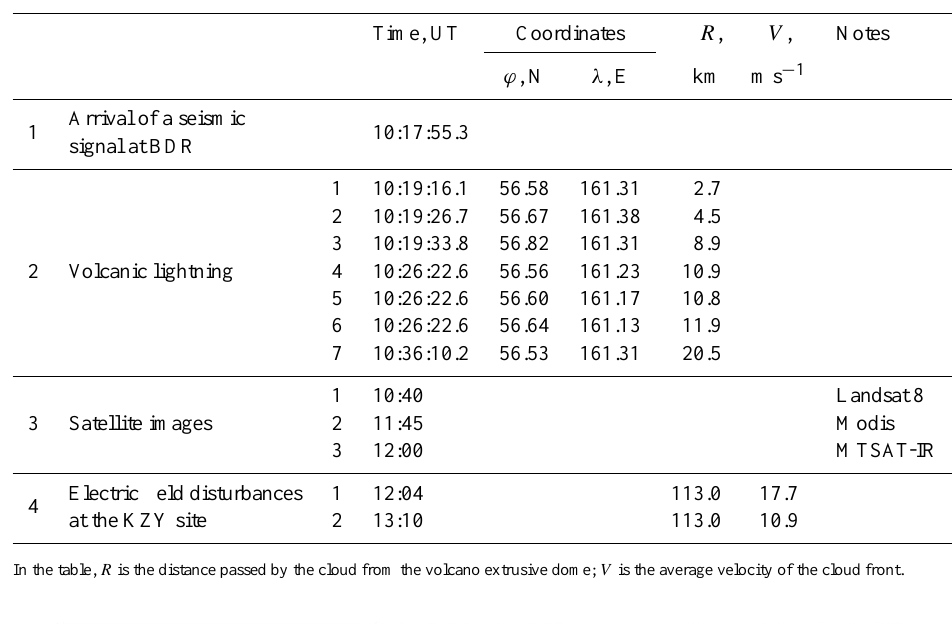
15 s corresponds to plume lightning activity. The seismic sig- nal is shown to decrease (Fig.